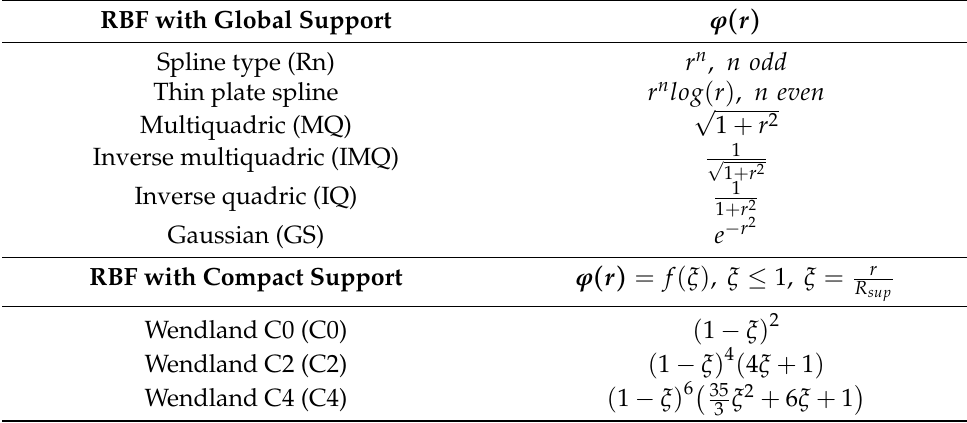
Table 1. Typical radial basis